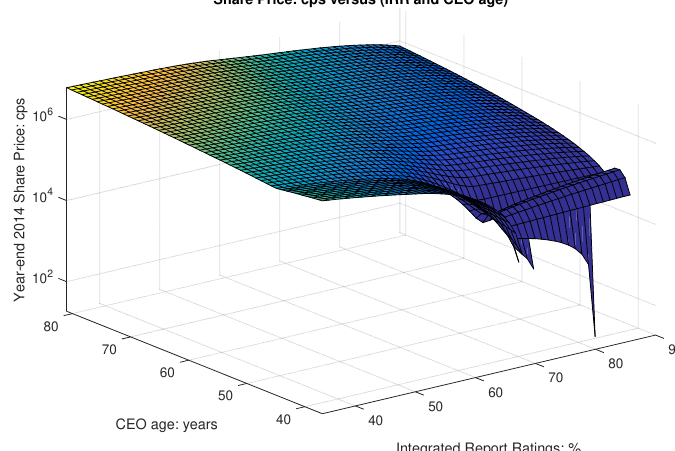
Fig. 5. ANOVA functions: Share price versus IRR and CEO age: Top-106 JSE listed companies